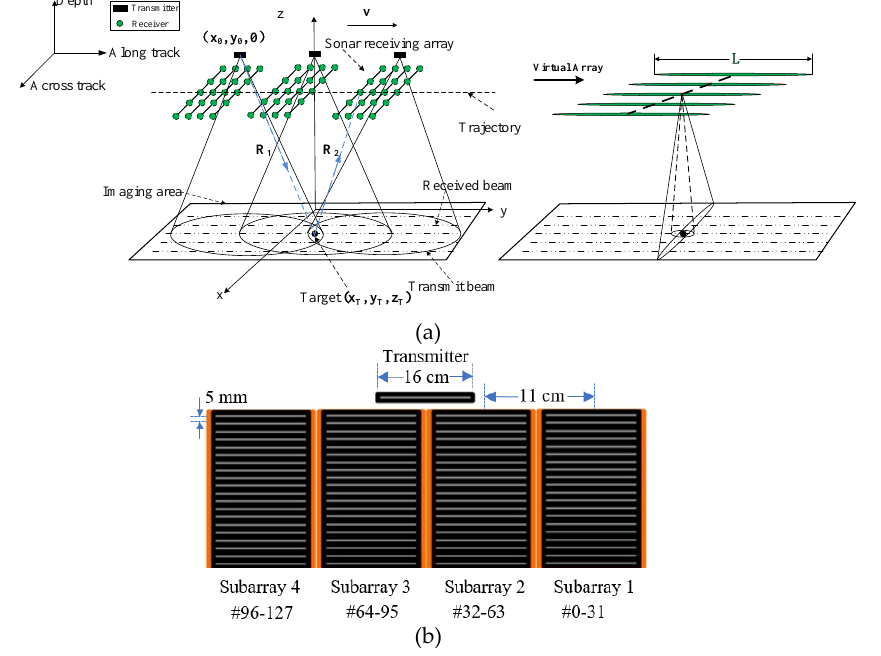
Figure 1. ( a ) Basic echo model of multibeam synthetic aperture sonar (MBSAS). ( b ) Designed 2D MBSAS transducer